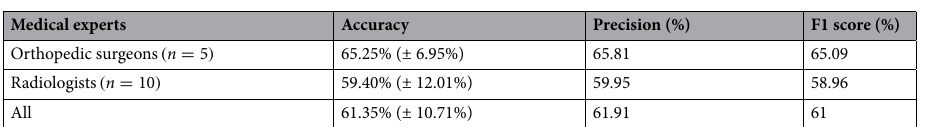
Table 1. Medical expert accuracy, precision, and F1 score in classifying images as real or DeepFake, with standard deviations shown in parentheses. F1 score refers to the harmonic mean of the precision and recall metrics.